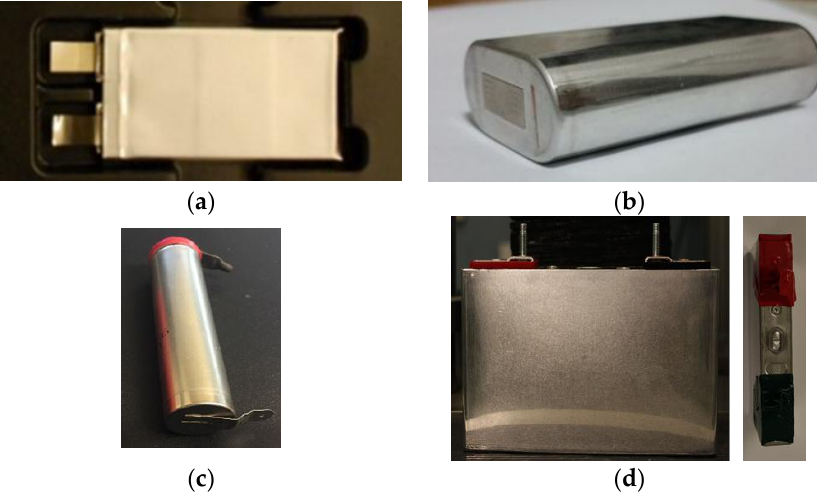
Figure 1. Four types of commonly used Li-ion batteries: ( a ) Pouch; ( b ) Elliptical; ( c ) Cylindrical; ( d ) Prismatic. Figures are from the study presented in [9,37,45,46].